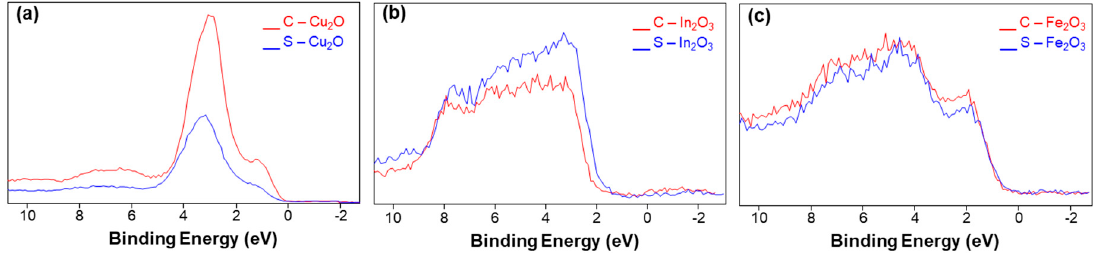
Figure 3. XP Valence Band Spectra in ( a ) Cu 2 O, ( b ) In 2 O 3 , and ( c ) Fe 2 O 3 binary oxide samples.